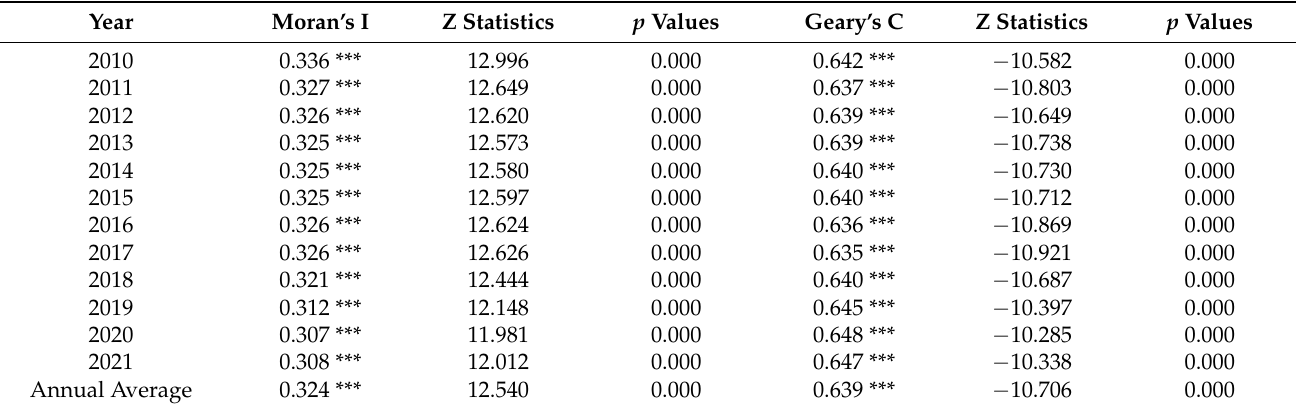
Table A1. Calculation results of Moran’s I and Geary’s C from 2010 to